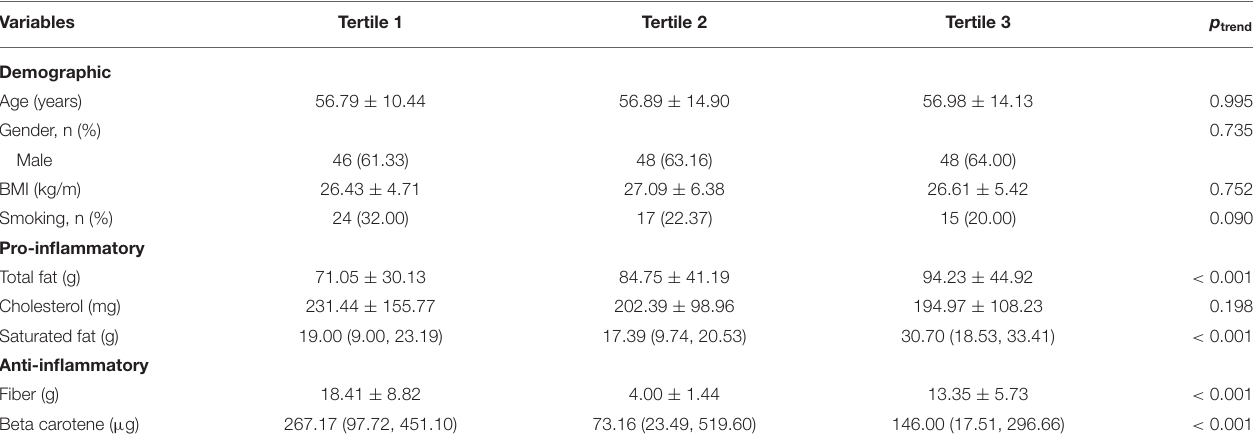
TABLE 2 | Characteristics of the participants according to the quartiles of dietary inflammatory index.